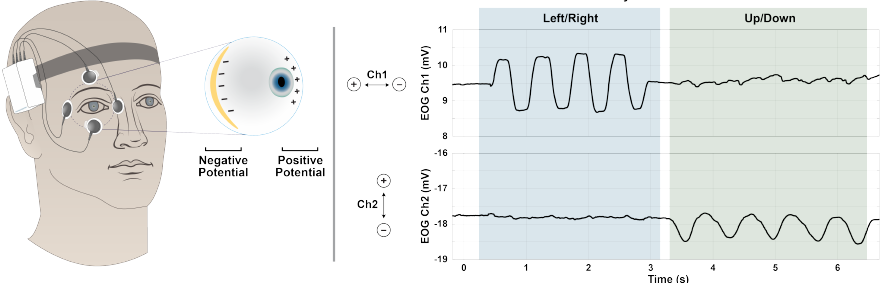
Figure 1: Voltage data obtained by EOG, and its relation to eye movements. Eye movements are correlated with changes in voltage measured by the surface electrodes. The electrode configuration shown was used in this work, but is not the only